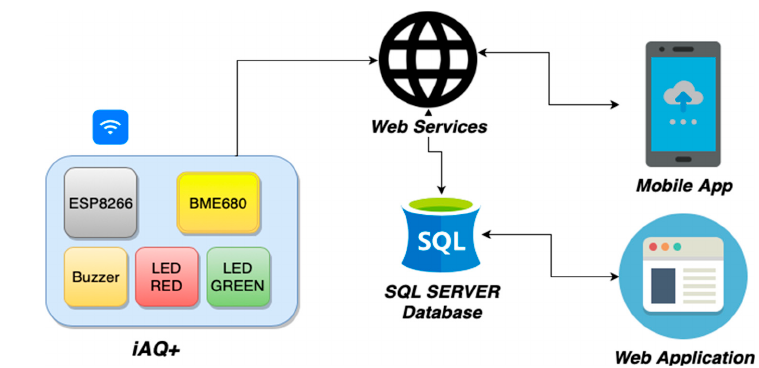
Figure 1. iAQ+ architecture.